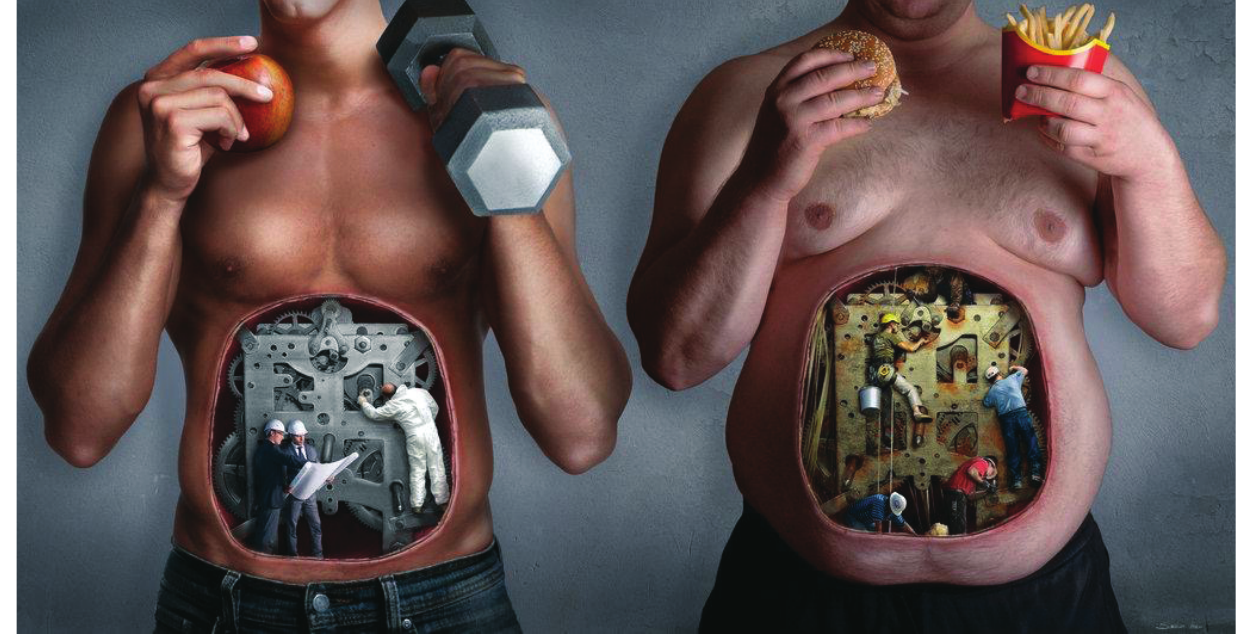
Figure 1. HFR “Tips for overcoming a weight loss plateau” (30 May